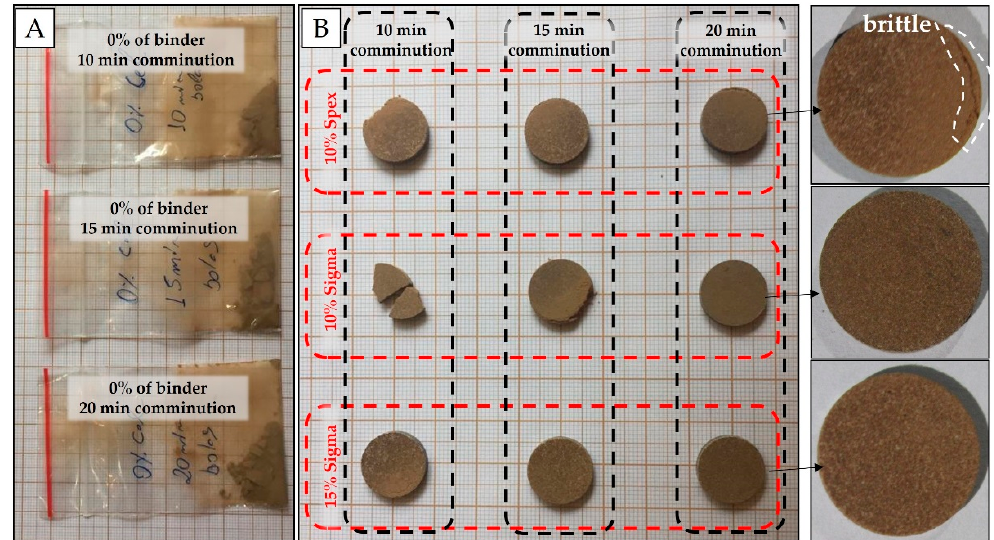
Figure 2. Soil samples without the addition of binder and with different grinding times ( A ); pellets resulting from tests with different grinding times, cellulose concentrations and brands ( B ).